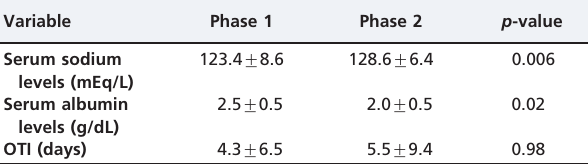
Table 2 - Serum sodium levels, serum albumin levels, and OTI time in the two phases of the study (mean ¡ sd).